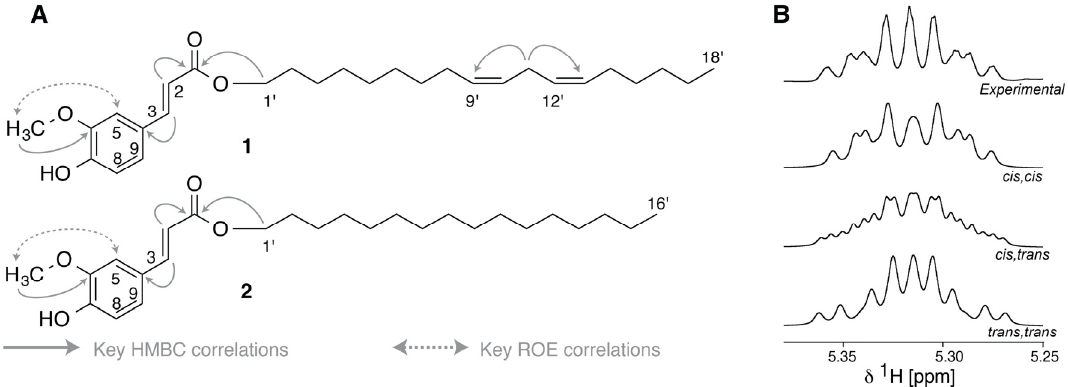
Figure 7. ( A ) Structure of linoleyl ferulate ( 1 ) and hexadecyl ferrulate ( 2 ) and selected HMBC and ROESY correlations; ( B ) Experimental (top) and simulated spectra (600 MHz) of the olefinic methine protons of the spin system -CH 2 -C H =C H -CH 2 -C H =C H -CH 2 where the coupling is 7 Hz to the external methylenes ( 3 J H-8,H-9 and 3 J H-13,H-14 ) and 6.6 Hz to the central methylene ( 3 J H-10,H-11 and 3 J H-11,H-12 ), whereas the olefinic methine protons are coupled with 10 Hz ( cis , cis ), 10 and 16 Hz ( cis , trans ) and 16 Hz ( trans , trans ). The chemical shift values of the methine protons were set to 5.333, 5.297, 5.295 and 5.335 Table 2. NMR spectroscopic data (DMSO- d 6 , 600 and 150 MHz for 1 H and 13 C, respectively) of compounds 1 and 2 acquired at 300 K.